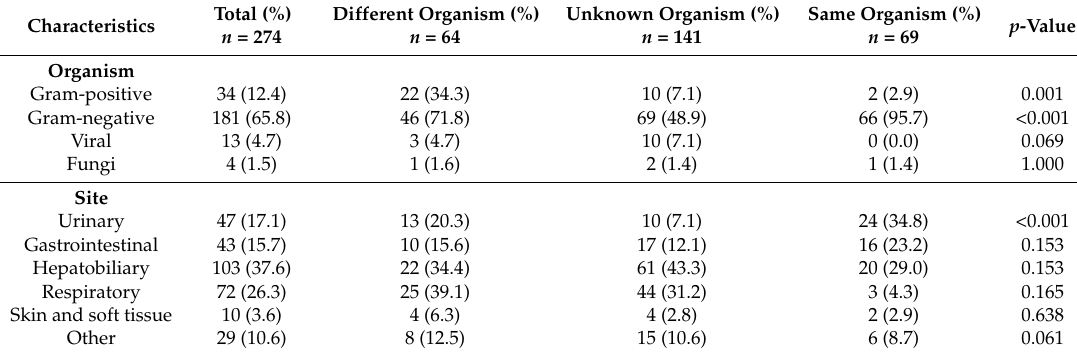
Table 2. Characteristics of Causal